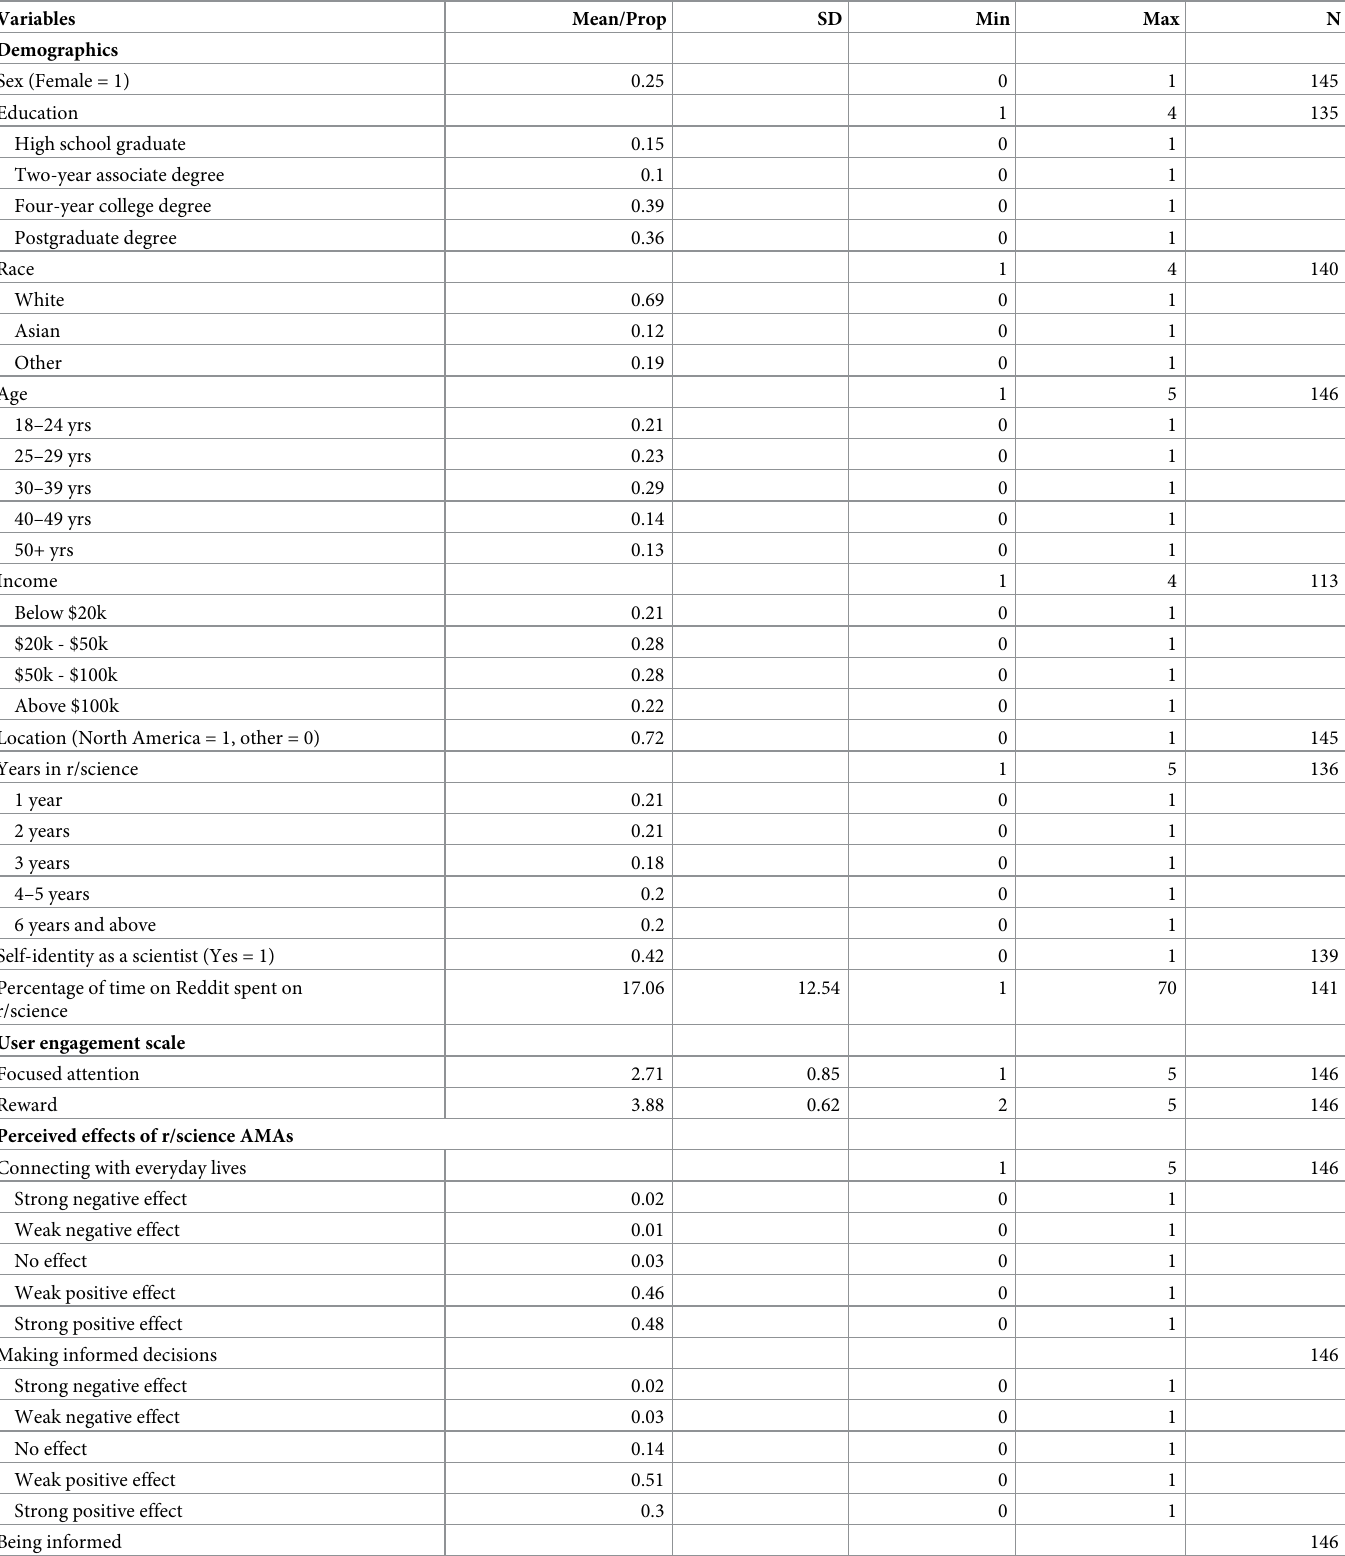
Table 1. Descriptive statistics of all